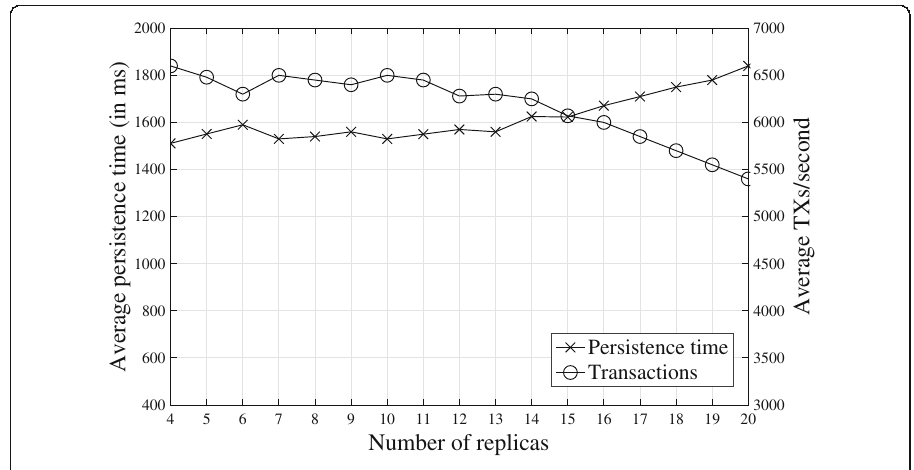
Fig. 3 Performance of the accounting